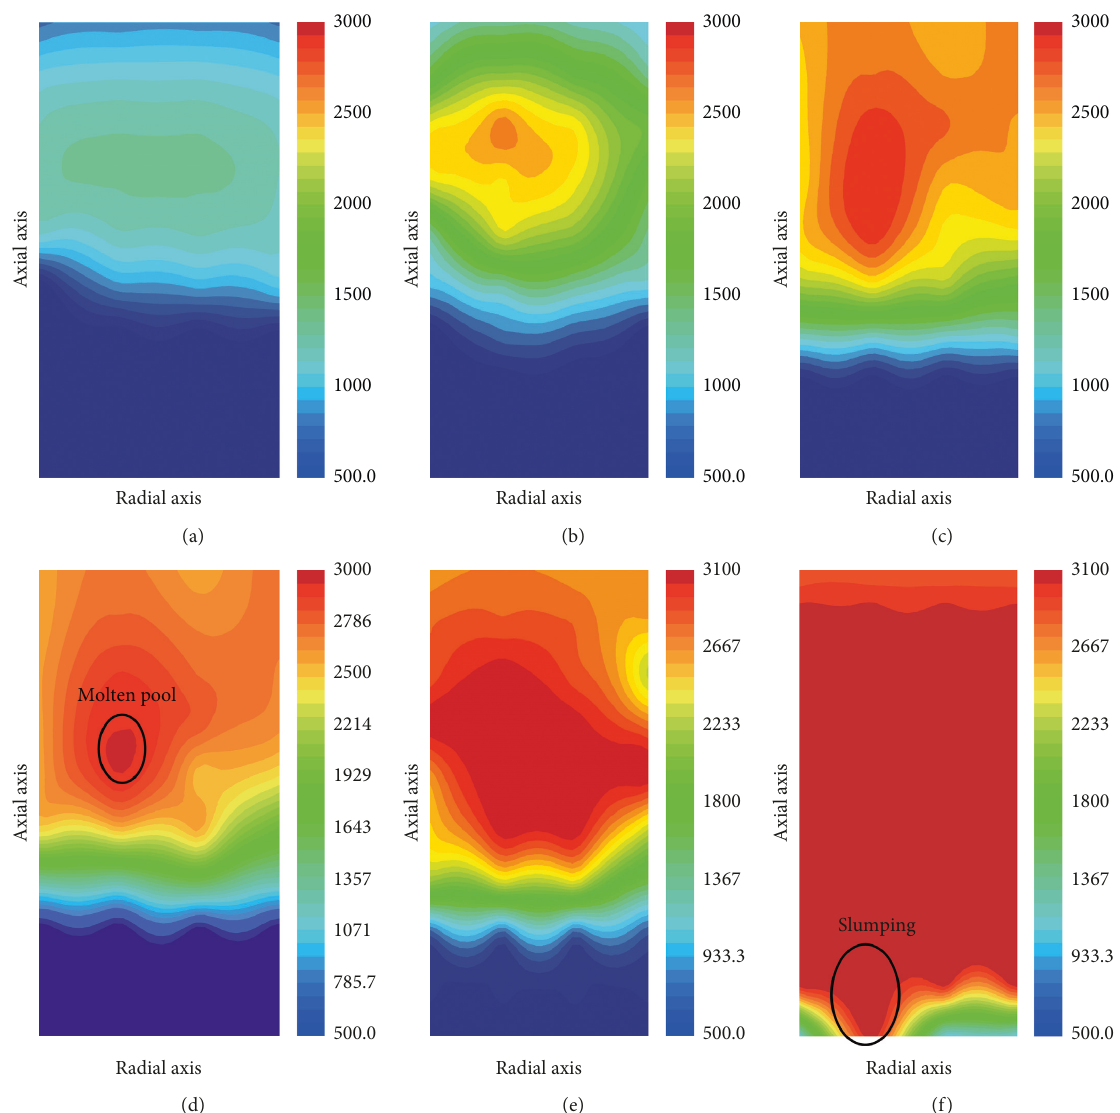
Figure 6: Temperature distribution of the core in depressurization. (a) Partial oxidation at 1400s. (b) Extensive oxidation at 1550s. (c) Beginning to melting at 1830s. (d) Molten pool formation at 1880s. (e) Molten pool expanding at 2400s. (f) Corium relocation at